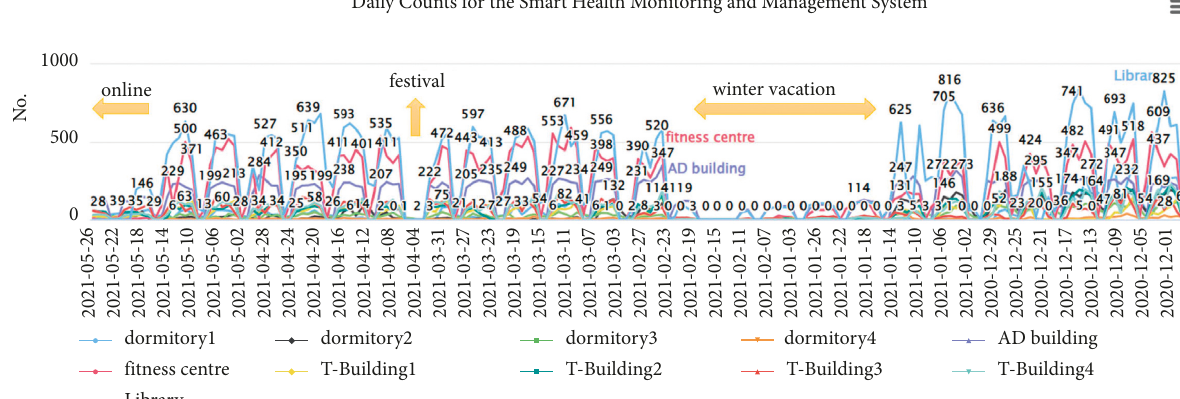
Figure 14: Daily counts at different sites for six months.